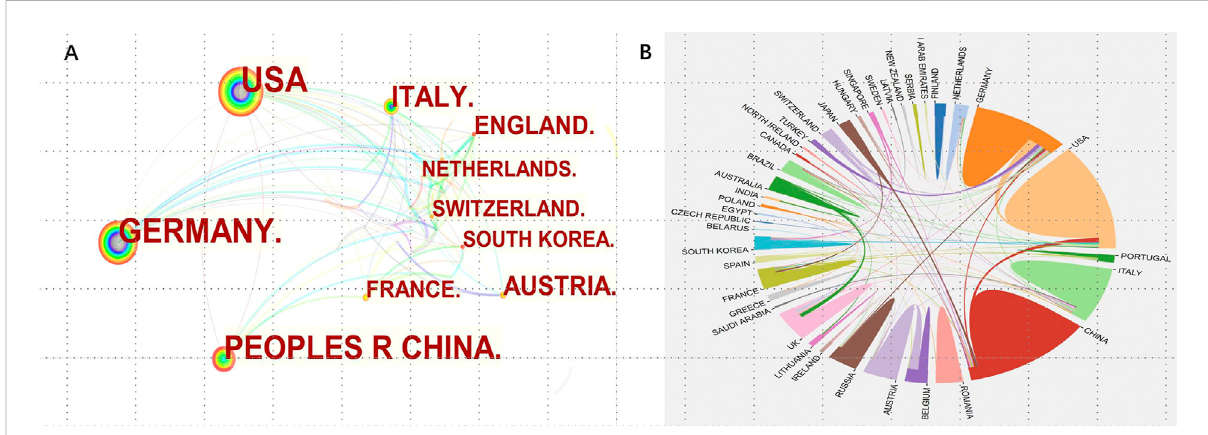
FIGURE 3 Cooperation of countries with regard to applications of TPP in biomedical fi eld. (A) The network of cooperative relations between countries generated with CiteSpace; (B) Visualized map of cooperative relations between countries (established with https://bibliometric.com).